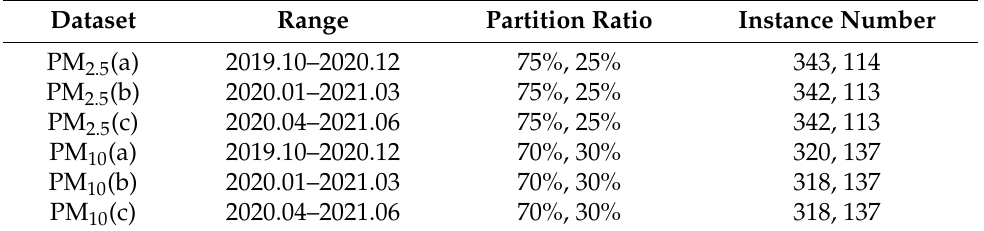
Table 2. Descriptions of the Beijing daily PM 2.5 and PM 10 concentrations in the experiments.